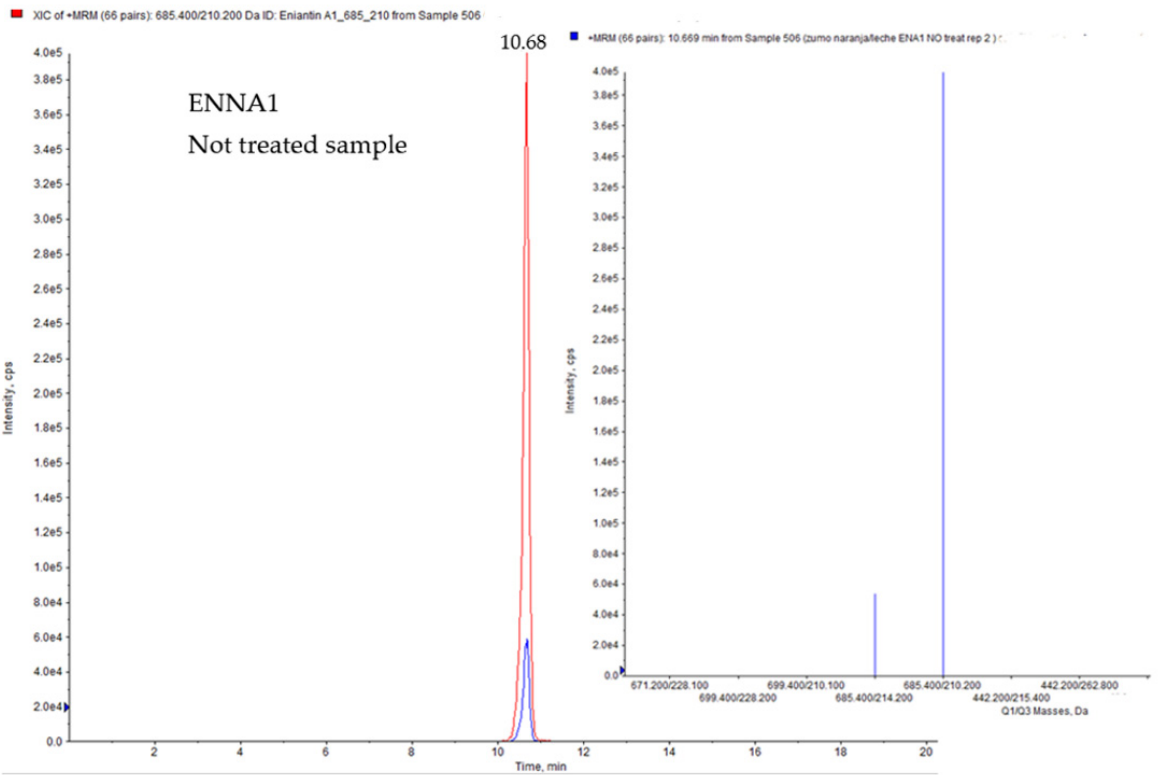
Figure 2. LC-MS/MS-IT chromatogram of orange juice/milk beverage contaminated by ENNA1 (100 µg/L), comparing thermal treated vs. non-treated.